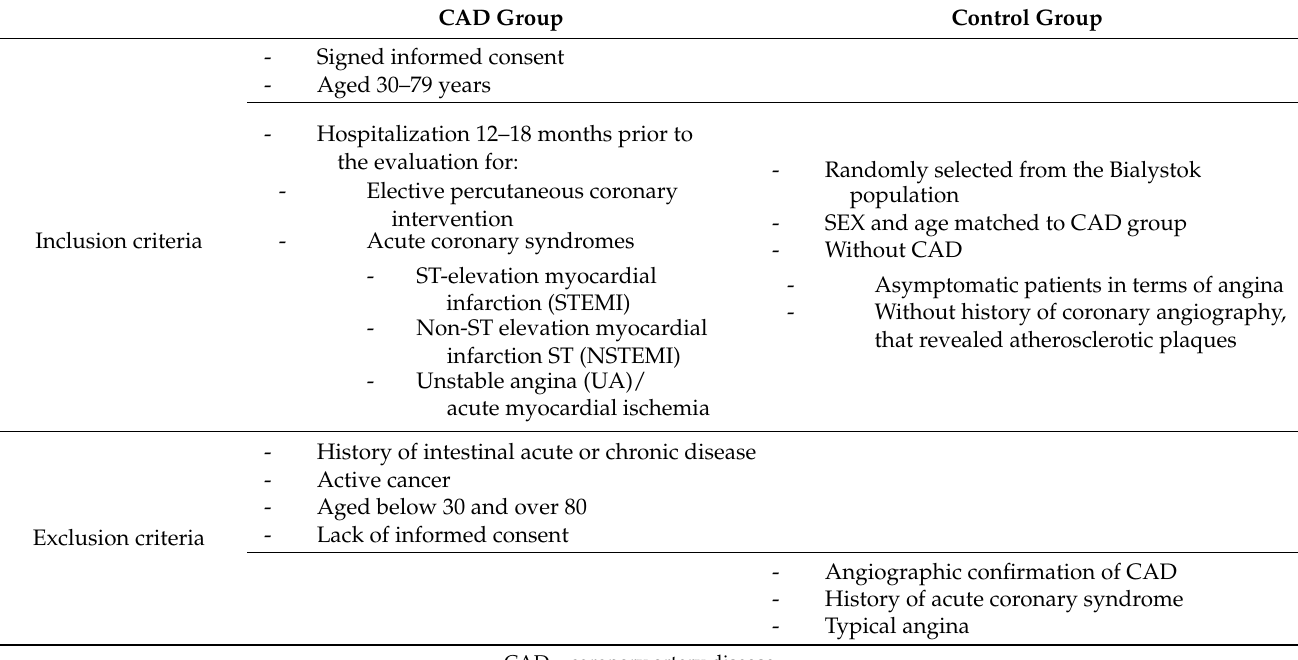
Table 1. The inclusion and exclusion